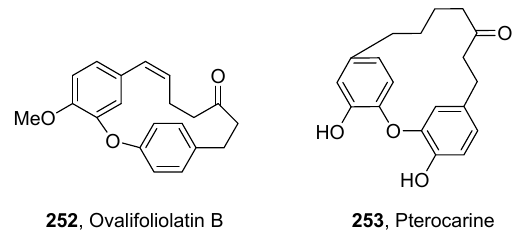
Figure 12. Relevant examples of macrocyclic diaryl ethers as natural compounds.